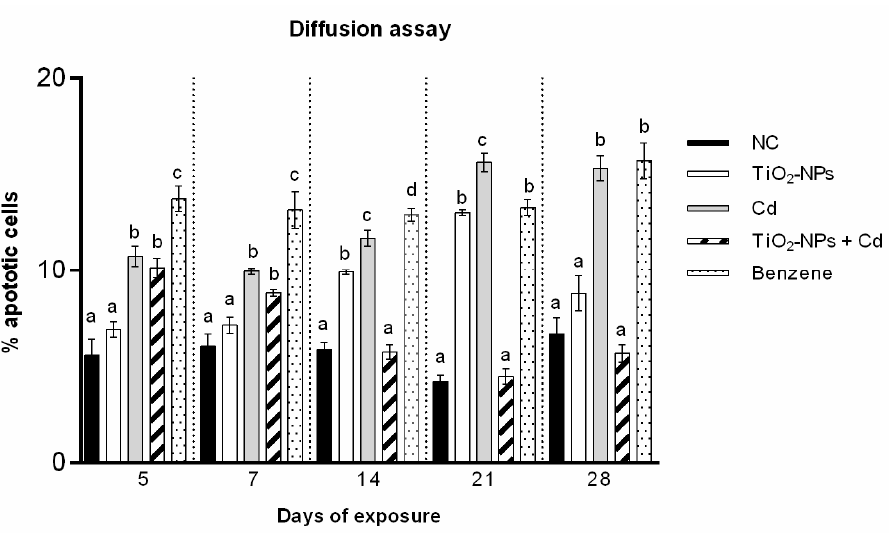
Figure 4. Percentage of apoptotic zebrafish blood cells ( n = 150) (ordinate) after different exposure times (abscissa) to TiO 2 -NPs, Cd and to TiO 2 -NPs + Cd co-exposure. The black bars are negative controls (NC); the white bars are 10 µ g/L TiO 2 -NPs; the grey bars are 1 mg/L Cd; the striped bars are 10 µ g/L TiO 2 -NPs + 1 mg/L Cd co-treated zebrafish. The dotted bars are positive controls (benzene 10 µ L/mL). Different letters correspond to diverse statistical significances (ANOVA)* p ≤ 0.05.